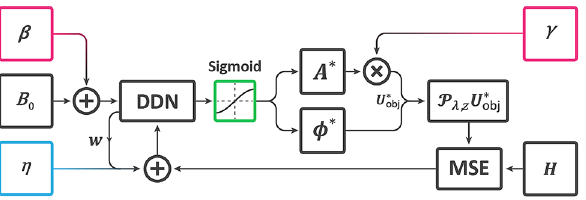
Figure 2. Structure of the DCOD algorithm. Colored boxes are the regularization elements.